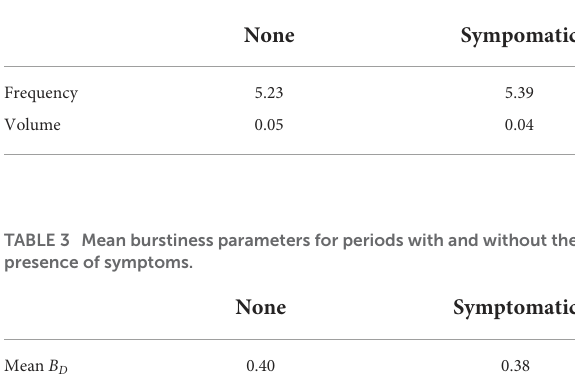
TABLE 1 Normalized mean daily amounts for transaction frequency and volume by symptom intensity.